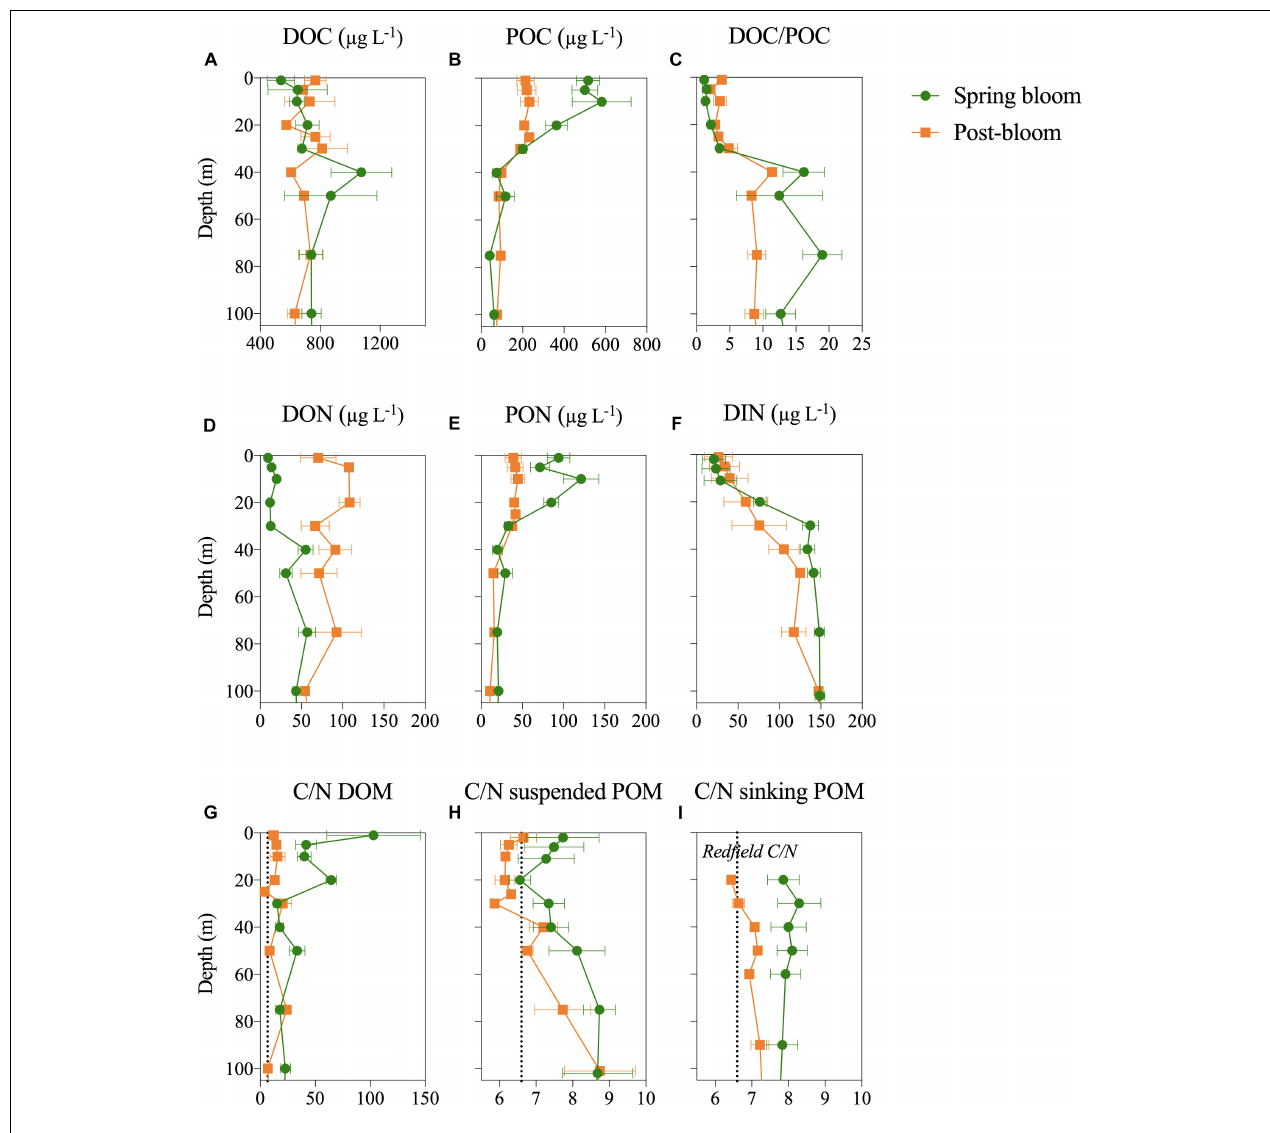
FIGURE 6 | Depth profiles of the C and N-pools. (A) Dissolved organic carbon (DOC), (B) particulate organic carbon (POC), (C) DOC/POC, (D,E) dissolved and particulate organic nitrogen (DON and PON, respectively) and (F) dissolved inorganic nitrogen (DIN). (G–I) The carbon to nitrogen ratios (atom:atom) of DOM, suspended POM and sinking POM retrieved from sediment traps. The Redfield C/N ratio is indicated by the vertical dotted line. All data is show as an average ± SE of the three stations sampled during the spring bloom in May (P1–P4) and post-bloom in August (P5–P7), respectively.